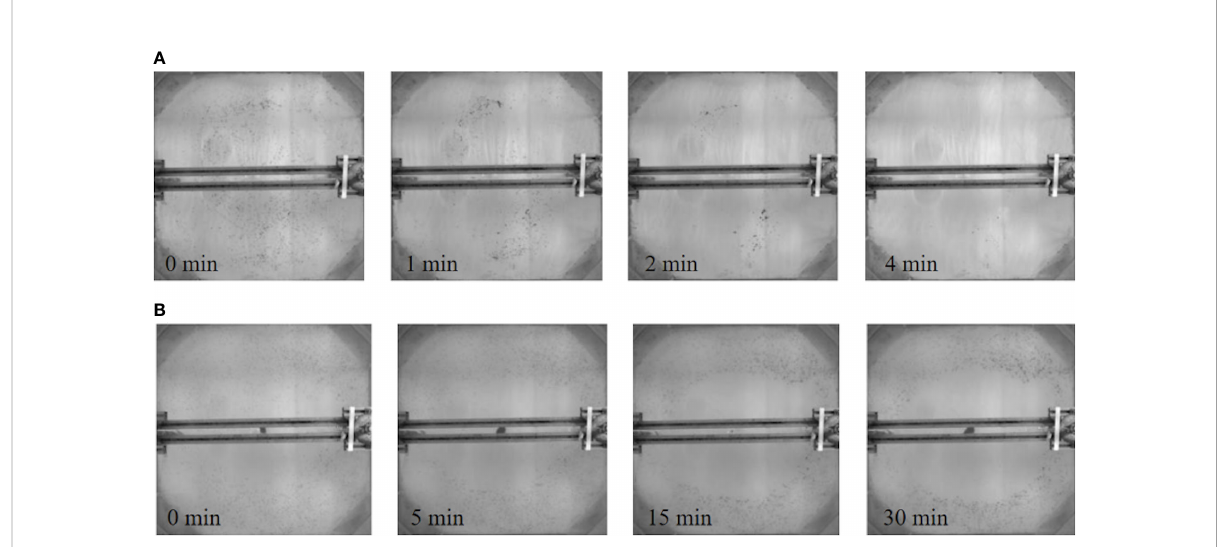
FIGURE 7 Samples of (A) complete and (B) incomplete solid waste removal processes within 30